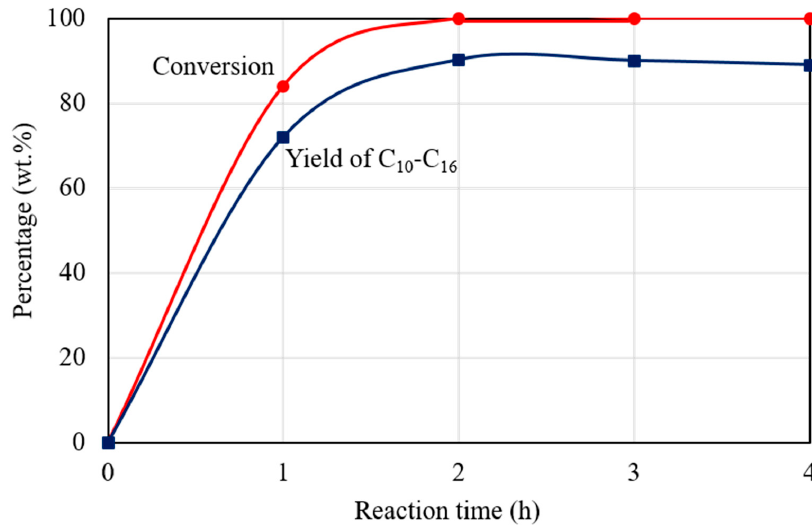
Figure 7. The dependence of C 15 H 31 COOC 16 H 33 conversion and C 10 ‒ C 16 hydrocarbon yield on the reaction time for the catalytic deoxygenation of C 15 H 31 COOC 16 H 33 in H 2 atmosphere, at 300 °C, over 1 wt.% Pd/Mg(Al)O catalyst. Reaction conditions: C 15 H 31 COOC 16 H 33 : 5 g; catalyst: 0.2 g; H 2 pressure at 25 °C: 0.9